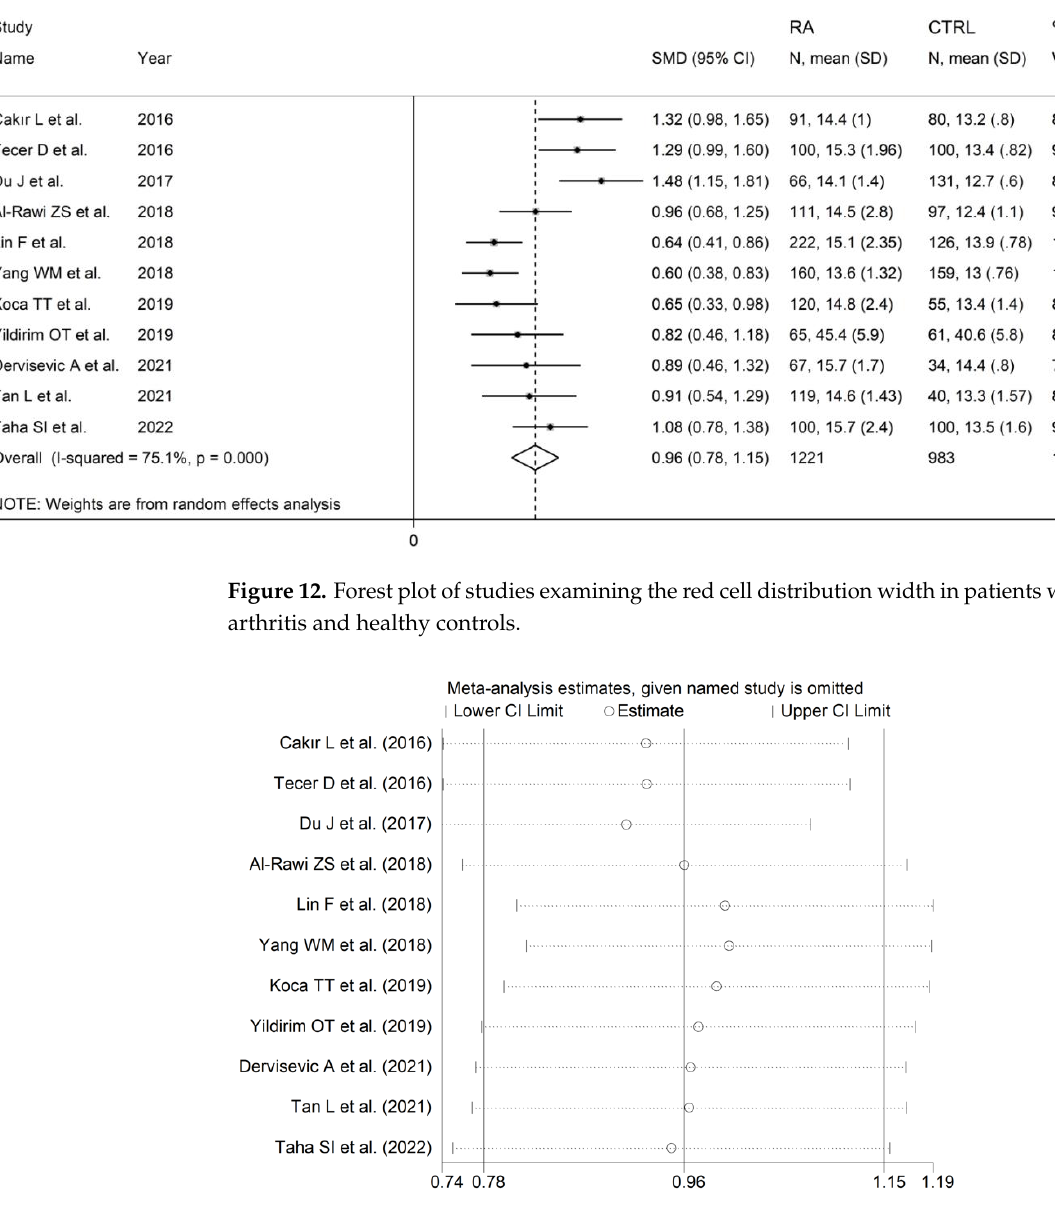
Figure 13. Sensitivity analysis of the association between the red cell distribution width and rheuma-